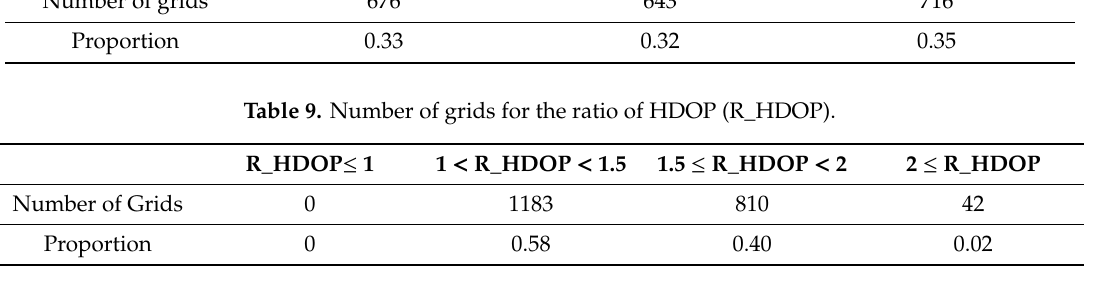
Figure 13. HDOP using Doppler differential positioning algorithm from channel 5 to channel 8.